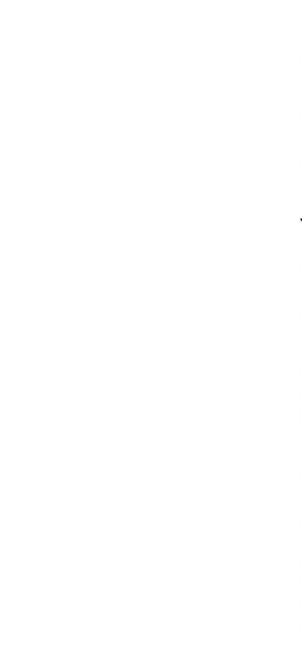
FIGURE 1 | Case presentation of case 1. CCRT, concurrent radiotherapy; CR, complete remission; CT, computed tomography; N, lymphonodus; PR, partial remission; PD, progression disease; RT, radiotherapy; T, tumor; TC,